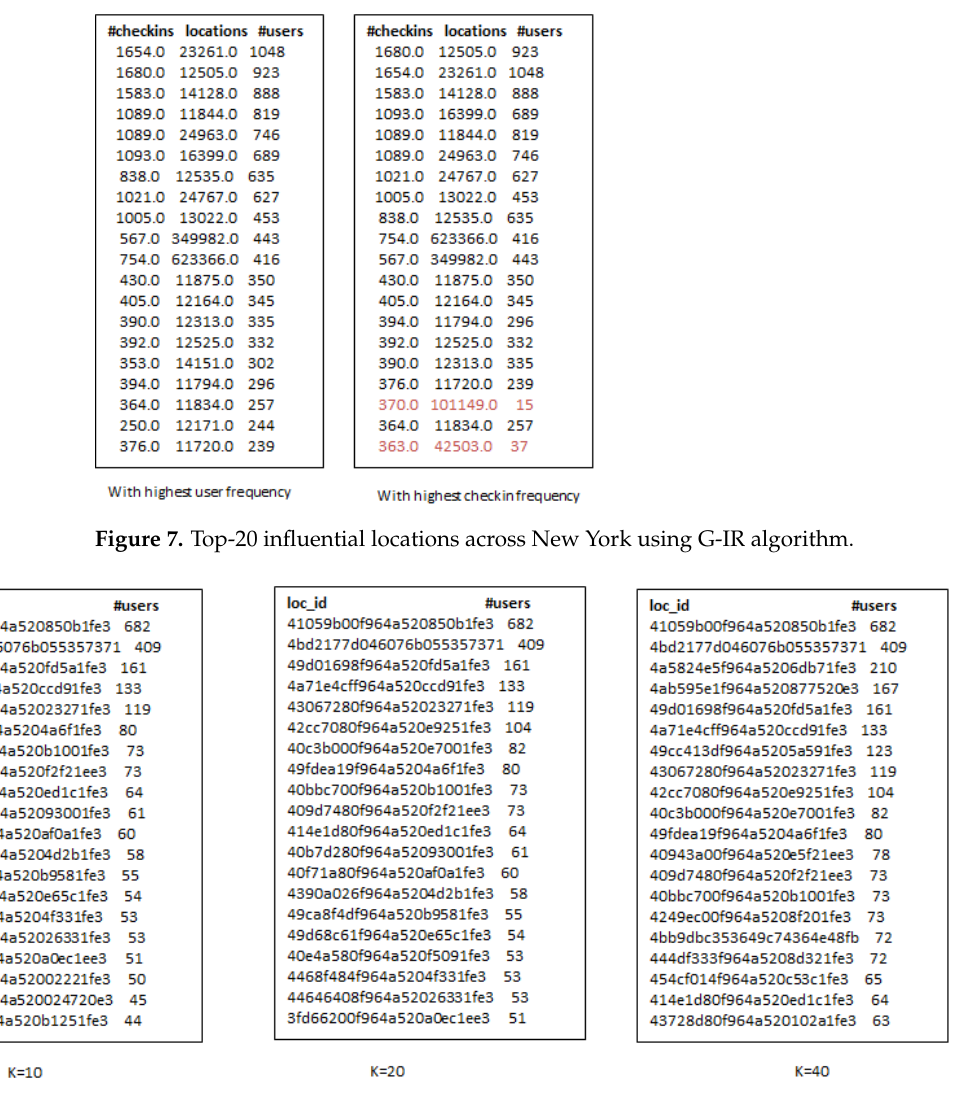
Figure 8. Top-20 influential locations across San Francisco using RF-algorithm on